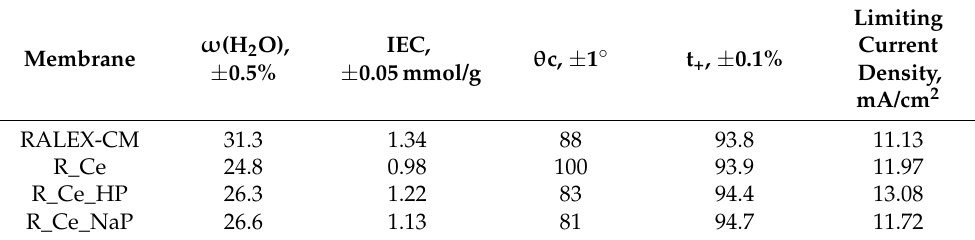
Table 1. Water uptake ( ω (H 2 O)), ion exchange capacity, water contact angle ( θ c, from the modified side), cation transport numbers (t + ), and limiting current density for the composite RALEX-CM